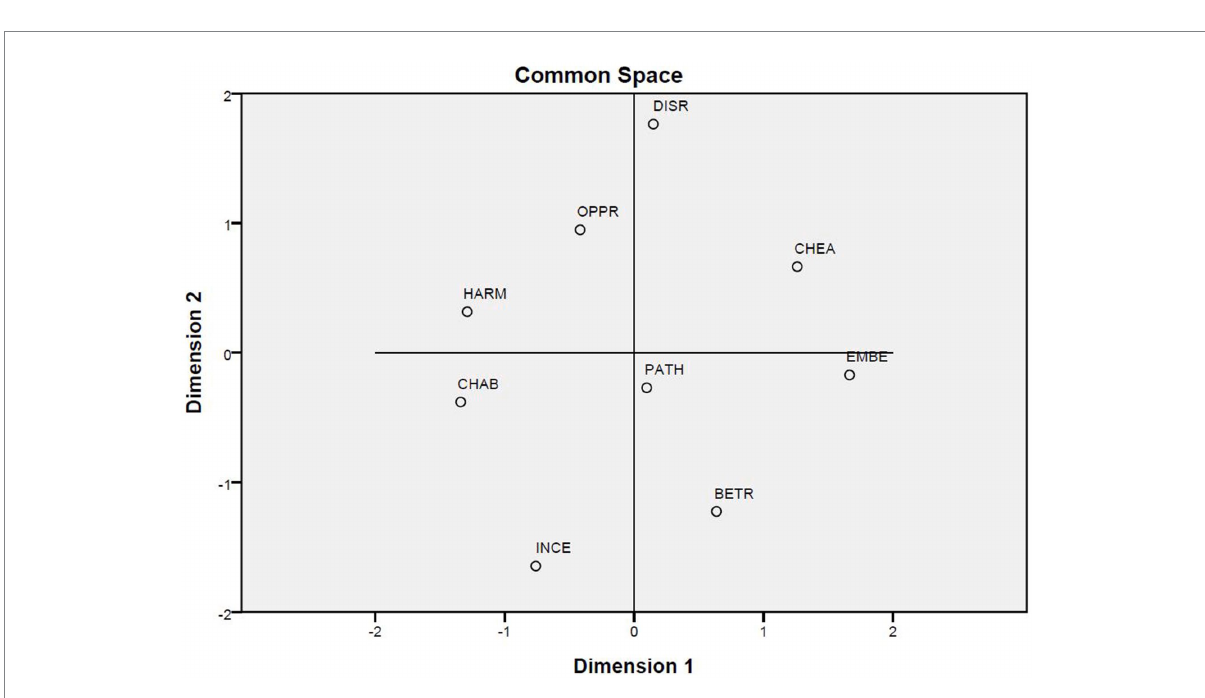
FIGURE 3 The distribution of the nine situations in a two-dimensional